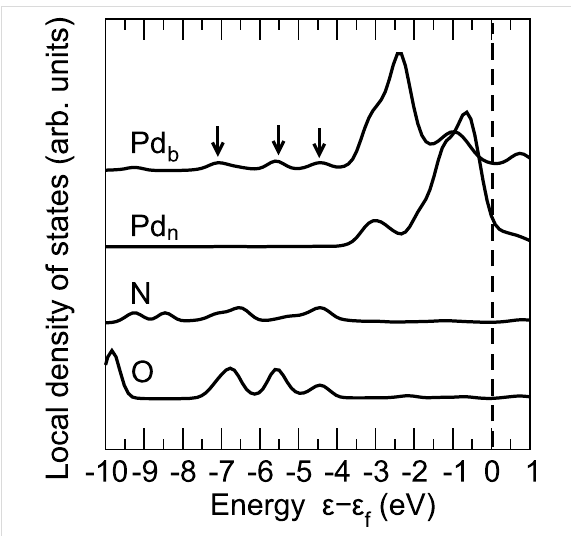
Figure 4: Local density of states (LDOS) of the Au/Mpy/Pd/H 2 O com- plex at a water coverage of = 1/3 ML. Plotted, from the top, is the LDOS of the Pd b atom bound to the nitrogen atom of 4-mercap- topyridine and the oxygen atom of the water molecule, of the Pd n atom not interacting with any molecules, of the nitrogen atom (N) of the 4-mercaptopyridine molecule, and of the oxygen atom of the water molecule (O). The bonding states between Pd b , N, and O atoms are marked with arrows. Figure 5: Charge density difference in an isodensity representation